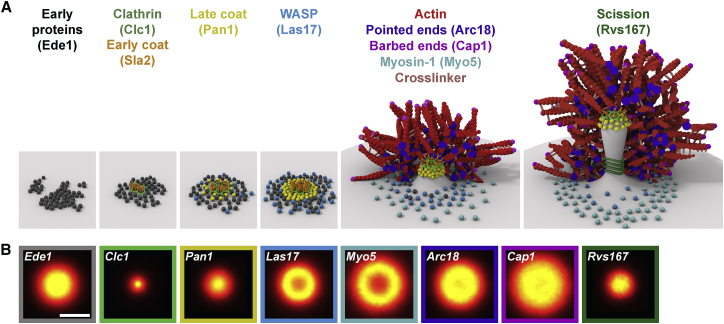
The Endocytic Machinery Assembles via Peripheral Binding(A) Schematic representation of the assembly of the endocytic machinery (for description, see text).(B) Representative radial averages of endocytic proteins at key time points during assembly. Shown are Ede1 (early), Clathrin (Clc1, early coat), Pan1 (late coat), Las17 (WASP), Myo5 (Myosin-1), Arc18 (Arp2/3 complex bound to pointed ends), Cap1 (barbed ends), and Rvs167 (Scission).Scale bar represents 100 nm.